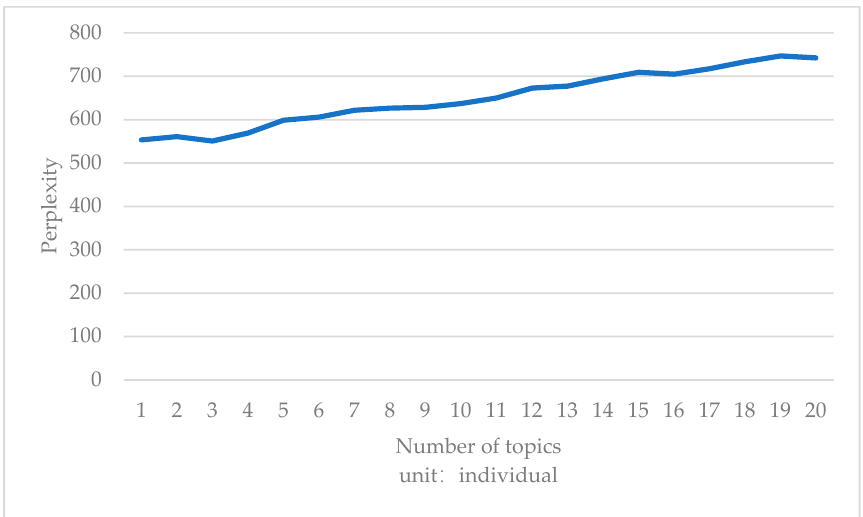
Figure 4. Perplexity of the number of topics before COVID-19.